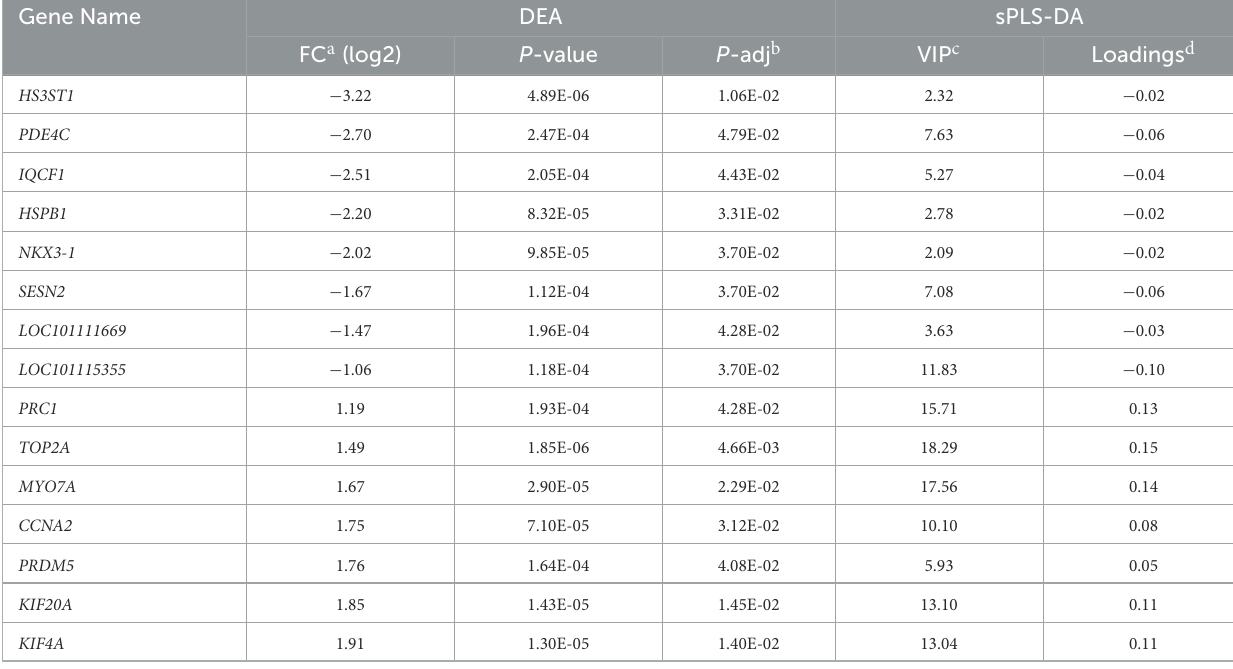
TABLE 1 Genes found in common by the differential gene expression analysis (DEA) and the sparse Partial Least Square-Discriminant analysis